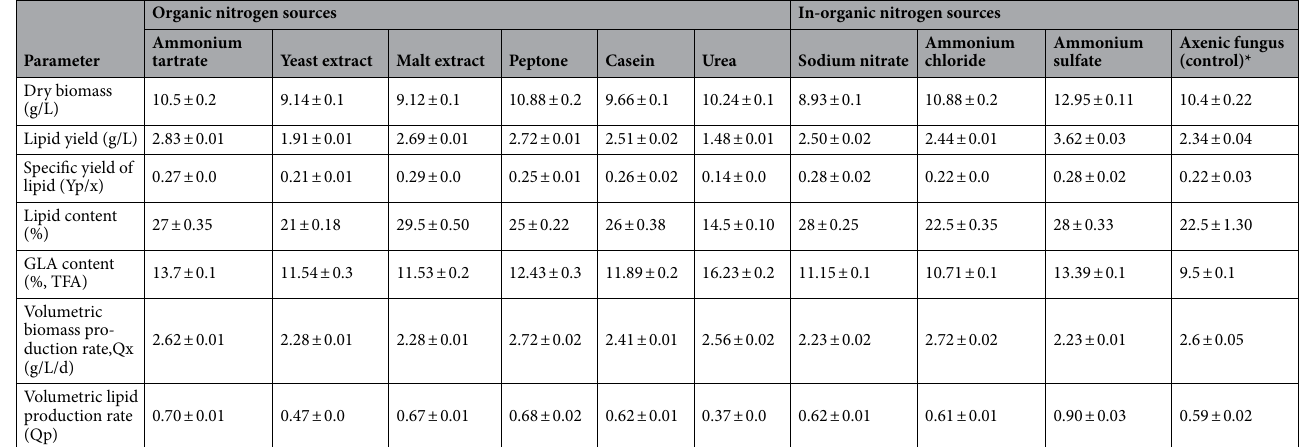
Table 2. Influence of different nitrogen sources on dry biomass, GLA and lipid production parameters by coculture fermentation. *Axenic fungus cultured on K&R medium containing glucose as a carbon source besides ammonium tartrate and yeast extract as nitrogen sources at pH 6.0 and 28 °C for 4